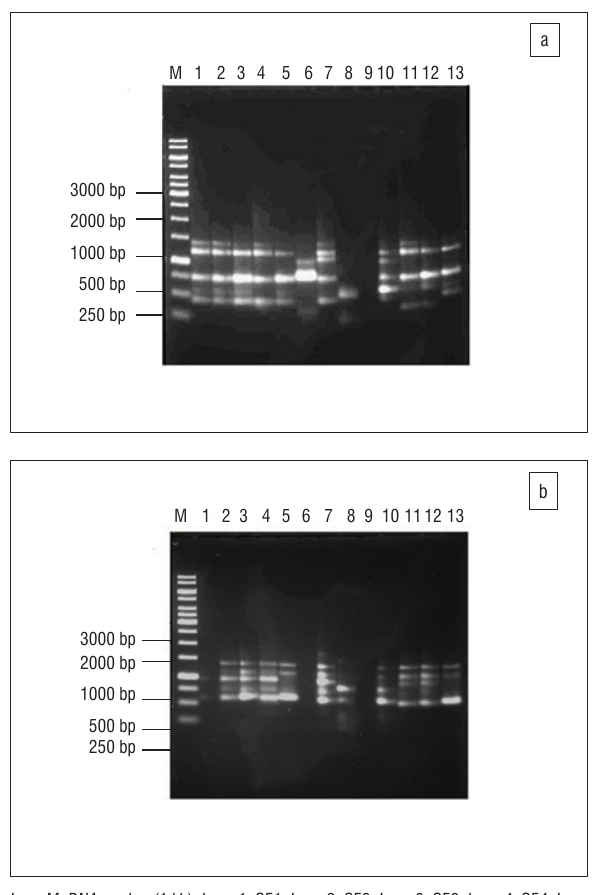
Figure 2: Agarose gel (1.2%) electrophoresis showing DNA fingerprinting of non-typhoidal Salmonella serotypes generated using (a) random amplified polymorphic DNA (RAPD 1) and (b) RAPD 3 primers.